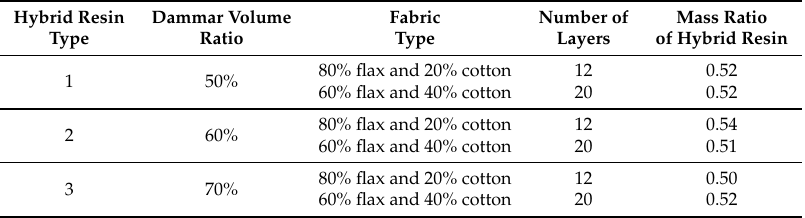
Table 1. The constituents of the manufactured composite